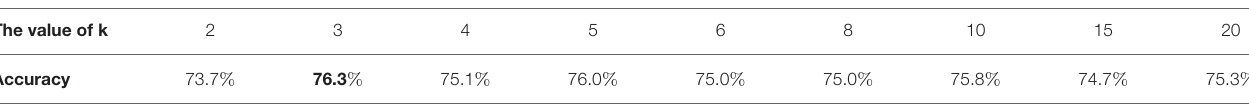
TABLE 7 | The classification accuracy with different k.